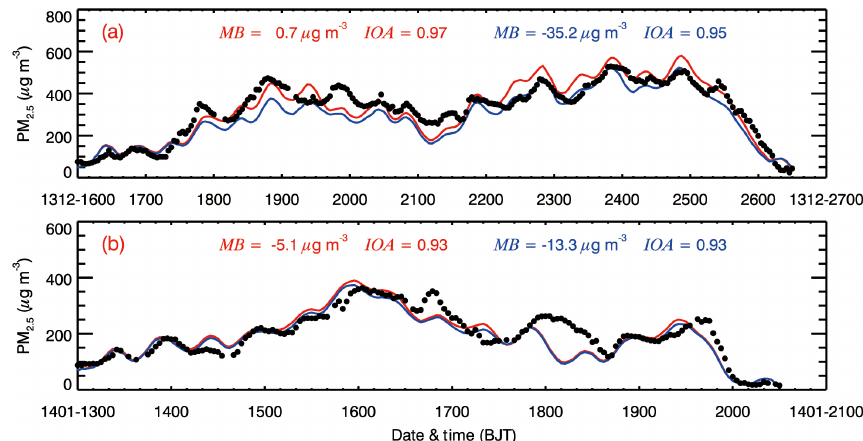
Figure 15. Comparison of measured and predicted diurnal profiles of near-surface hourly PM 2 . 5 mass concentration averaged over all ambient monitoring stations (a) in GZB from 16 to 27 December 2013 and (b) in BTH from 13 to 21 January 2014. The black dots represent the observations, and the solid red and blue lines are the simulations in the E-case and B-case, respectively.